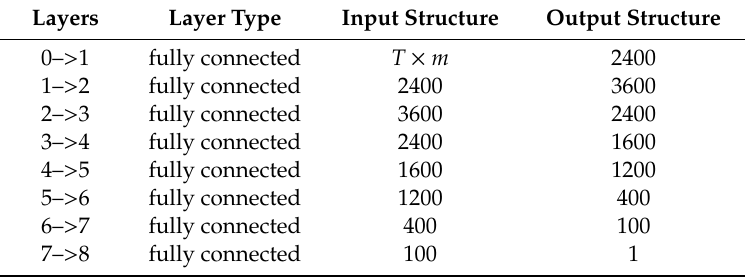
Table 1. The architecture of multilayer perceptron (MLP) with daily input data.